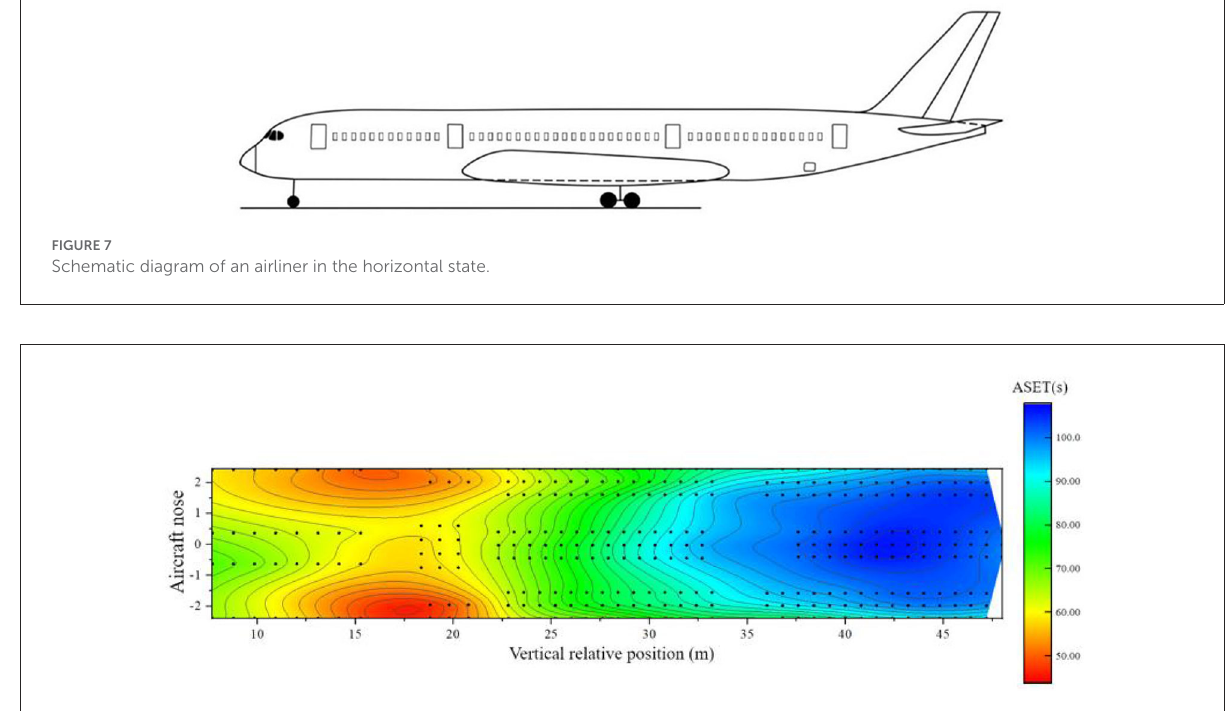
FIGURE8 Distribution of available evacuation time under horizontal cabin